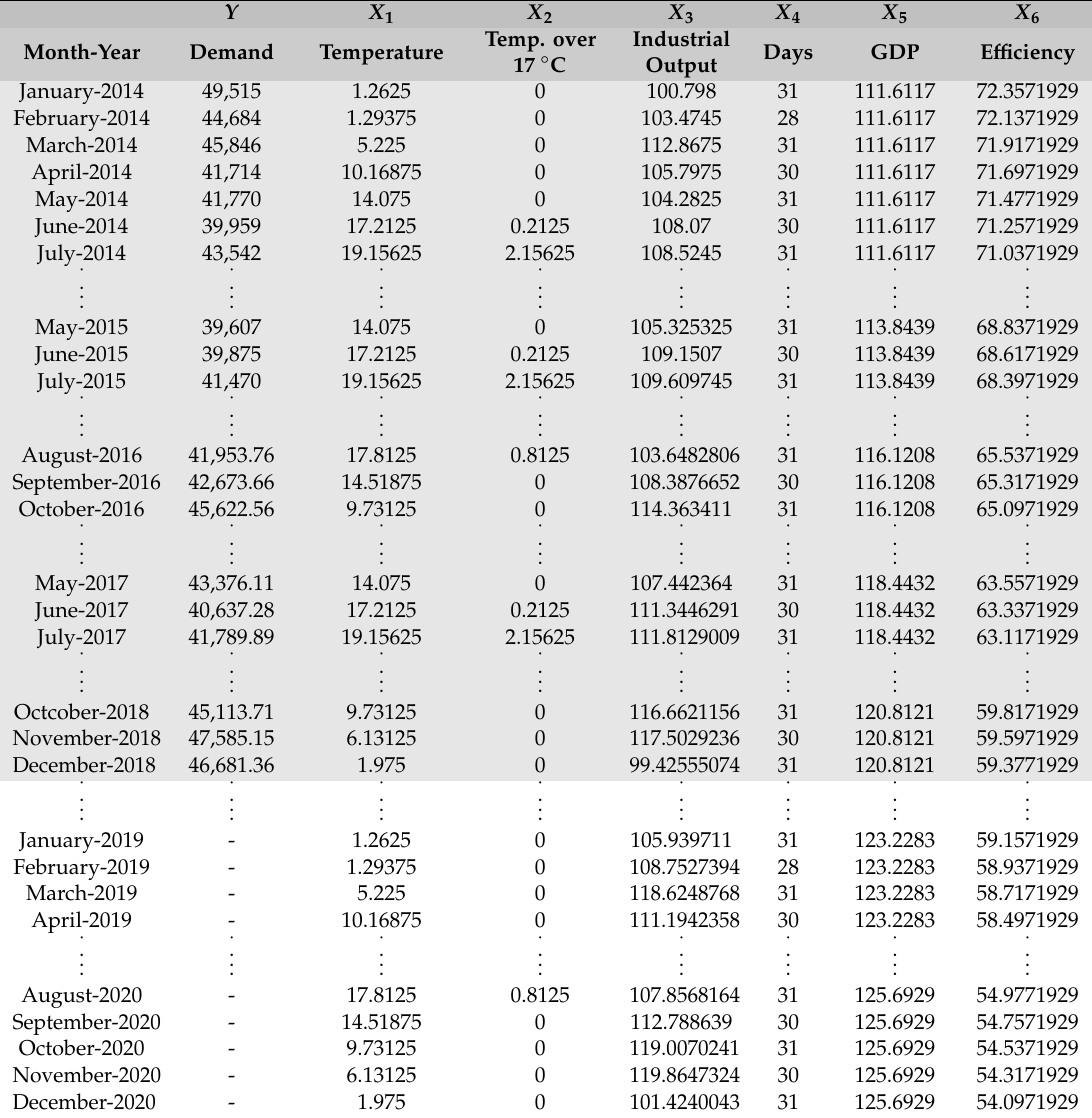
Table 3. Monthly data of the German market from 2013 to 2020 used to predict the